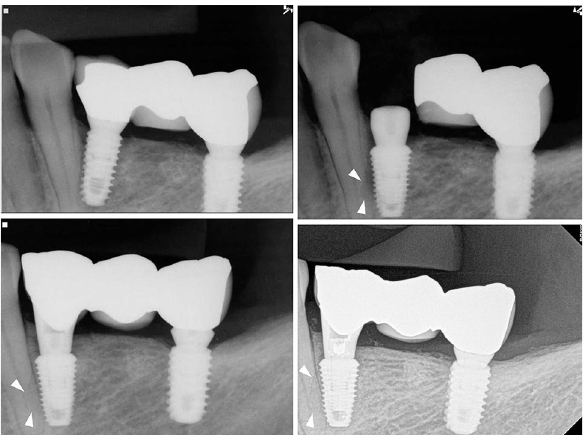
Figure 2. Direct invasion of the root (Group I); (left above) January 2013. (Right above) Osseointegration failed and a new implant was replaced. Arrows indicate trace of the old implant outline, February 2013; (left below) May 2013; (right below) injured tooth remained vital during 7-year functions, September 2020.